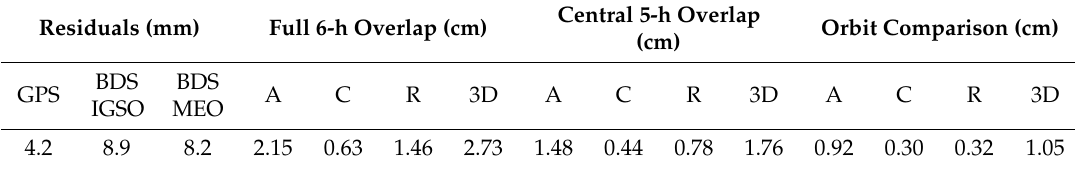
Table 6. Statistics of phase residuals, orbit overlap RMS of combined POD as well as orbit di ff erence RMS between combined POD and GPS-based POD in the along-track, cross-track, radial direction and